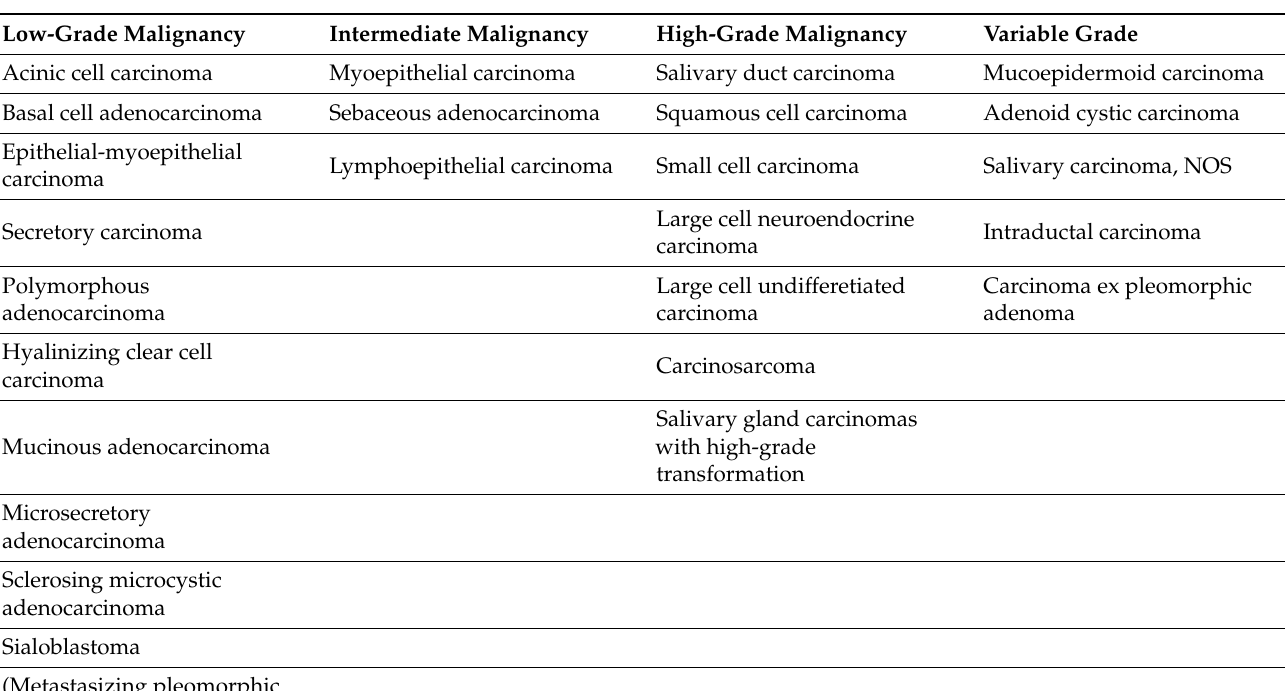
Table 2. Native histopathological stratification of salivary gland